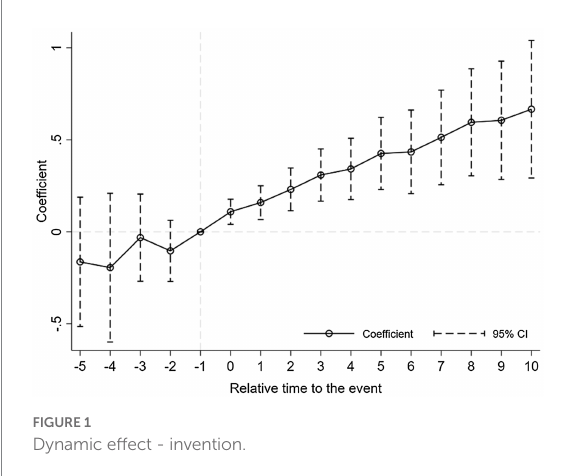
FIGURE 1 Dynamic effect - invention.